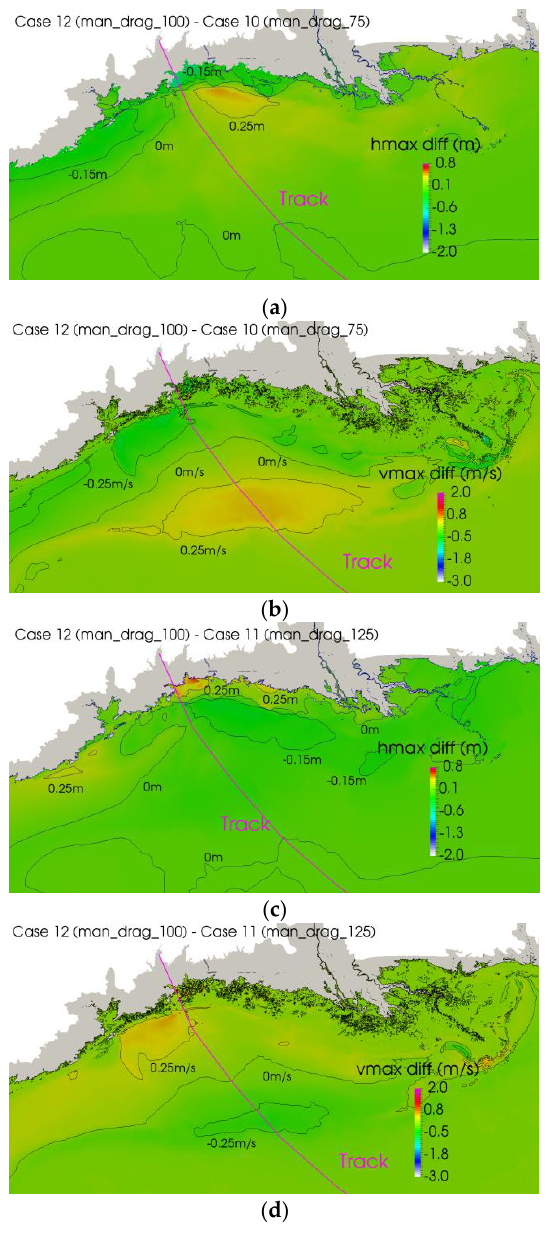
Figure 11. Contour plots of maximum water elevation and velocity for hindcast of Hurricane Rita storm surges. ( a ) maximum elevation difference: Case 12–Case 10; ( b ) maximum velocity difference: Case 12–Case 10; ( c ) maximum elevation difference: Case 12–Case 11; ( d ) maximum velocity difference: Case 12–Case 11.